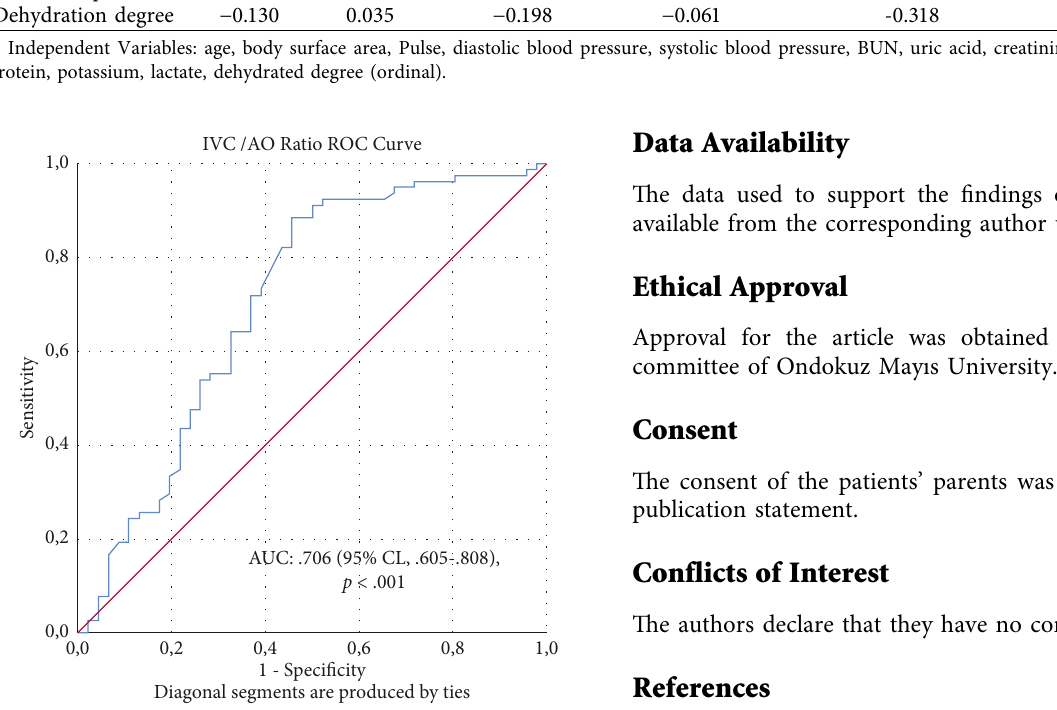
Figure 2: Receiver operator characteristic (ROC) curve of IVC/AO ratio to identify the degree of dehydration is